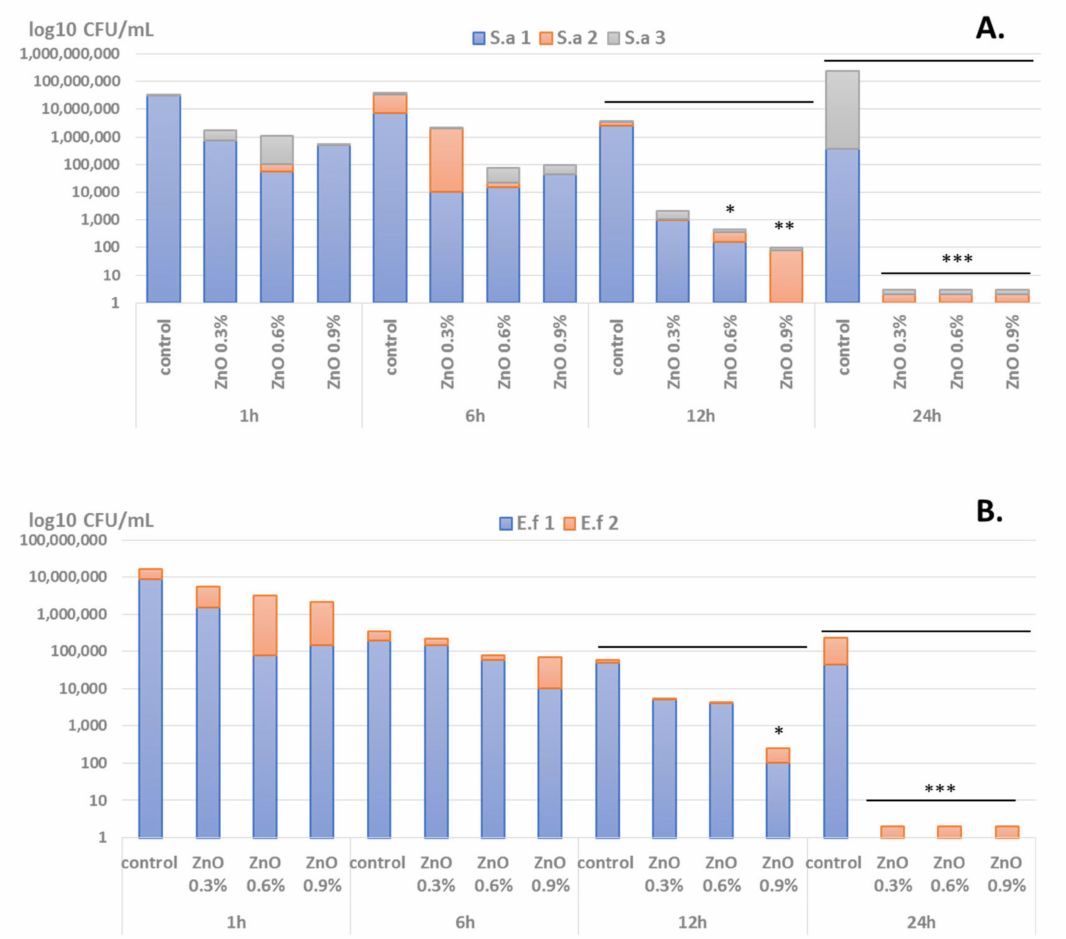
Figure 5. Graphical representation of log10 CFU/mL values obtained for the Gram-positive tested microbial strains (three S. aureus (S.a.) = ( A ) and 2 E. faecalis (E.f.) isolates = ( B )), expressing viability of bacteria incubated as 0.5 McFarland suspensions in PBS on the ZnO NPs-coated wound dressings for 1 h, 6 h, 12 h, and 24 h (* p < 0.05; ** p < 0.001; *** p < 0.0001 by comparing viability on control coatings with ZnO-coated